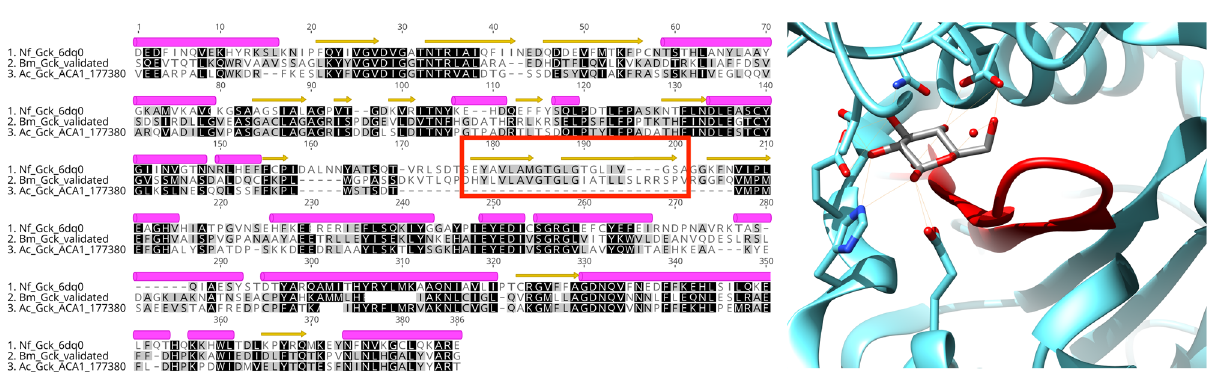
Figure 4. Sequence conservation of glucokinase in 3 pathogenic amoebas. Potential mis-assembly of the A. castellanii glucokinase (AmoebaDB ACA1_177380) highlighted on a multiple sequence alignment with the B. mandrillaris validated sequence (this study) and N. fowleri crystal structure (PDB: 6DA0) 15 ; helical regions are annotated as pink tubes and beta-sheets as yellow arrows. The alignment was obtained with T-Coffee- Expresso 27 . The double-stranded beta-sheet missing in A. castellanii glucokinase is colored in red on the active site of the B. mandrillaris structure (PDB: